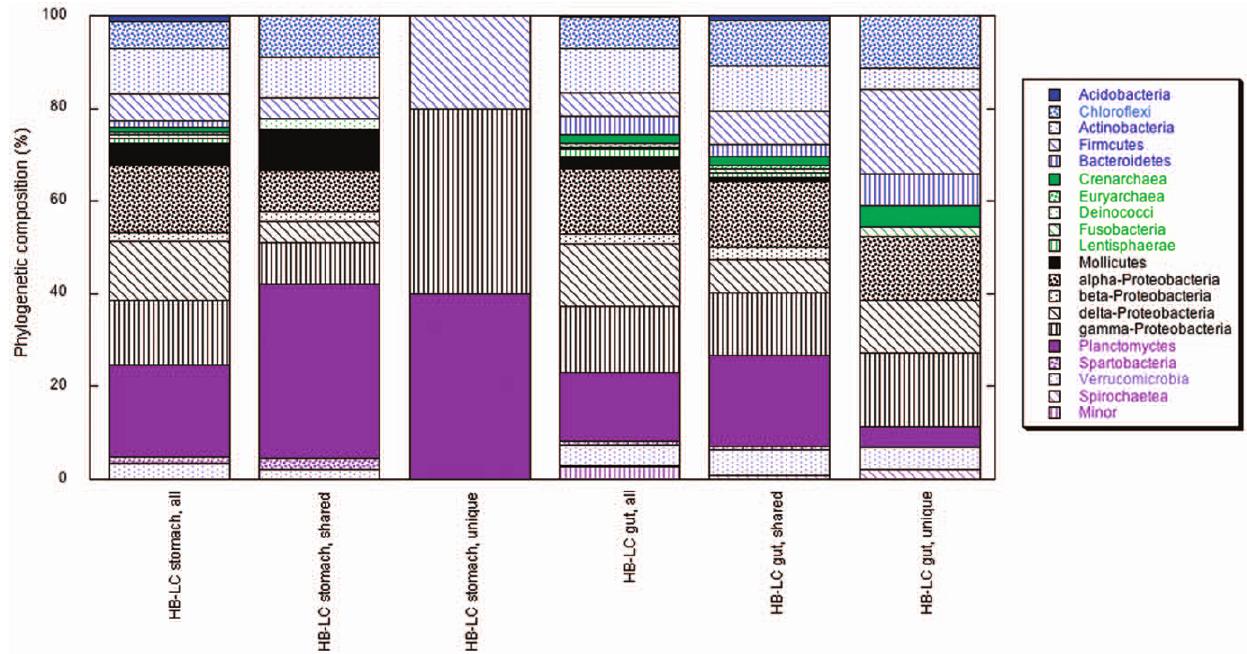
Figure 2. Phylogenetic composition (phyla and classes) of all OTUs found in pooled Hackberry Bay (HB) and Lake Caillou (LC) stomach or gut microbiomes; OTUs found in (shared among) all stomach replicates or all gut replicates for both sites (SHR-S and SHR-G, respectively); OTUs found exclusively in all stomach or gut replicates (SHRU-S and SHRU-G, respectively). See text for further details.